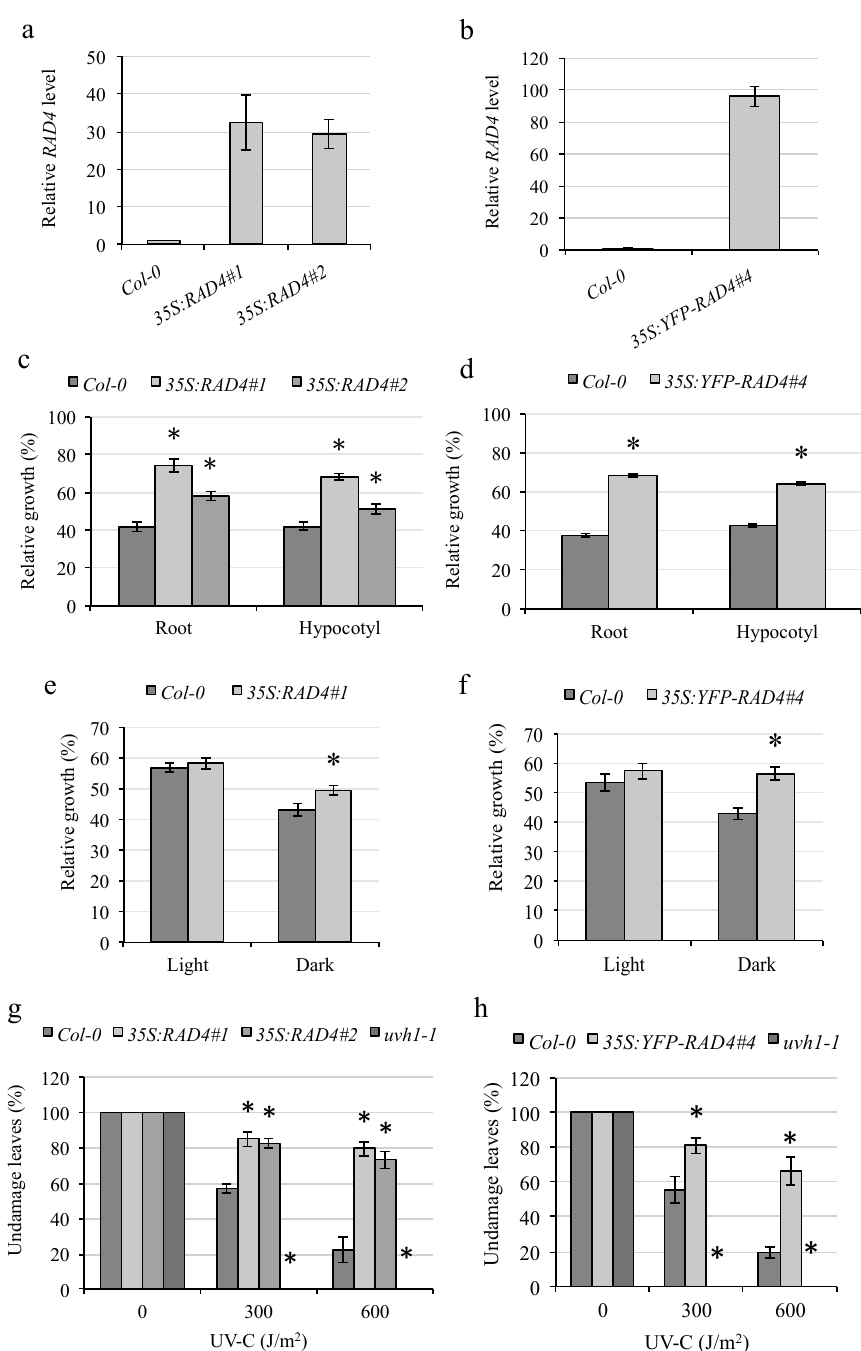
Figure 1. Overexpression of Arabidopsis Radiation sensitive 4 (RAD4) and yellow fluorescent protein (YFP)-RAD4 results in increased tolerance of ultraviolet (UV) radiation. RAD4 levels in ( a ) 35S:RAD4 and ( b ) 35S:YFP-RAD4 overexpression lines, relative to control Col-0. The values are normalized relative to the reference gene EF1 α . The error bars indicate SE ( n = 2). ( c – h ) UV tolerance in 35S:RAD4 and 35S:YFP-RAD4 overexpression lines. ( c , d ) Hypocotyl and root growth in dark-incubated seedlings analyzed 3 days after UV treatment, expressed as relative to the untreated controls ( n = 10). ( e , f ) Root growth in light- and dark-incubated seedlings analyzed 2 days after UV treatment, expressed as relative to the untreated controls ( n = 10). ( g , h ) Percentage of undamaged leaves in adult plants after 0, 300, or 600 J m − 2 UV treatment followed by dark incubation ( n = 6). For c–h, the values are means ± SE, * = p < 0.05 for the overexpression lines versus Col-0 wild type in the same conditions.